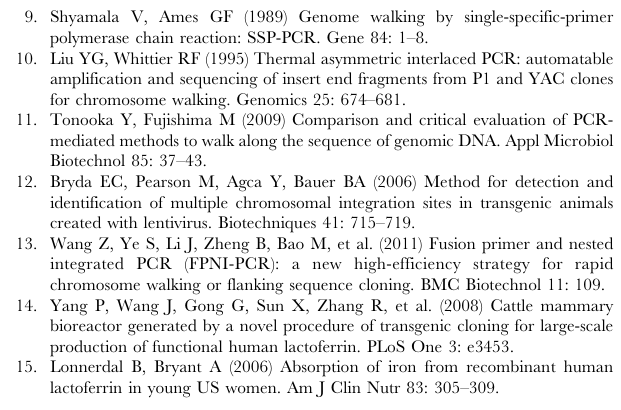
Figure S1 Verification of the integration sites of the transgene by PCR. PCR detection of the (A) 5 9 flanking region